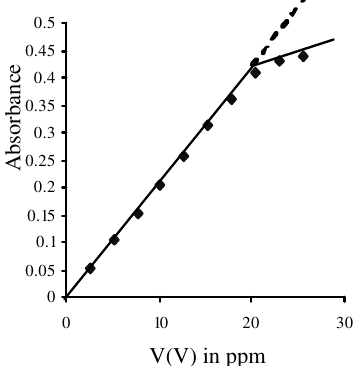
Figure 1. Beer’s Law Plot for V(V)- HnPBAO